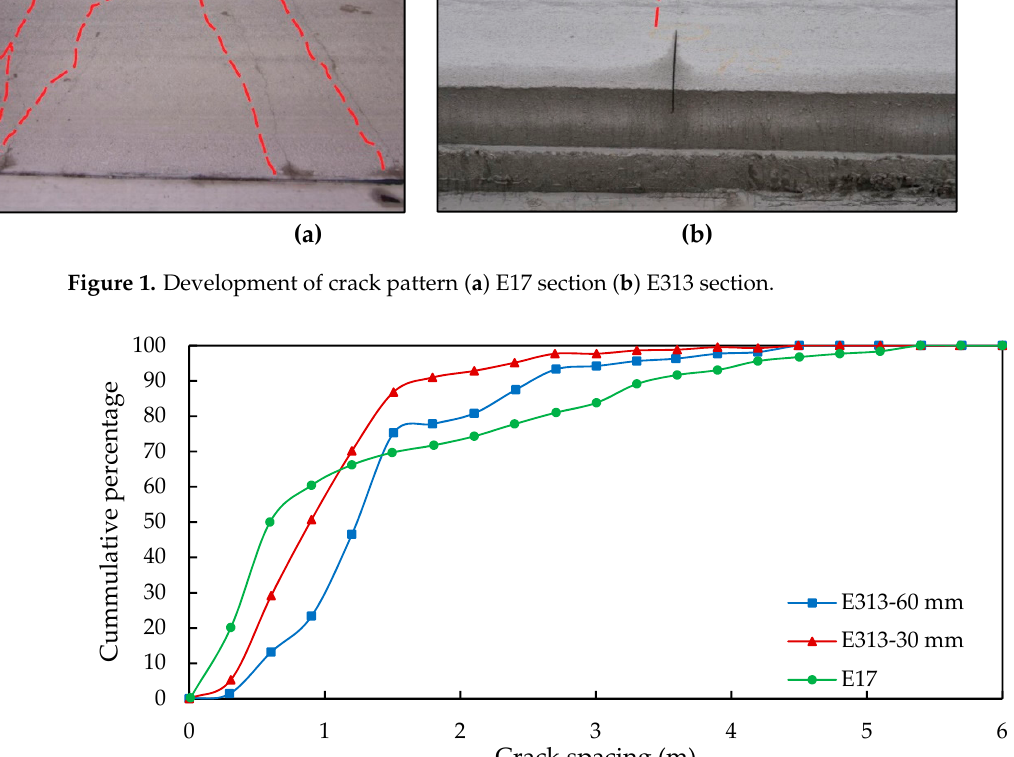
Figure 2. Comparison of cumulative crack spacing distribution.